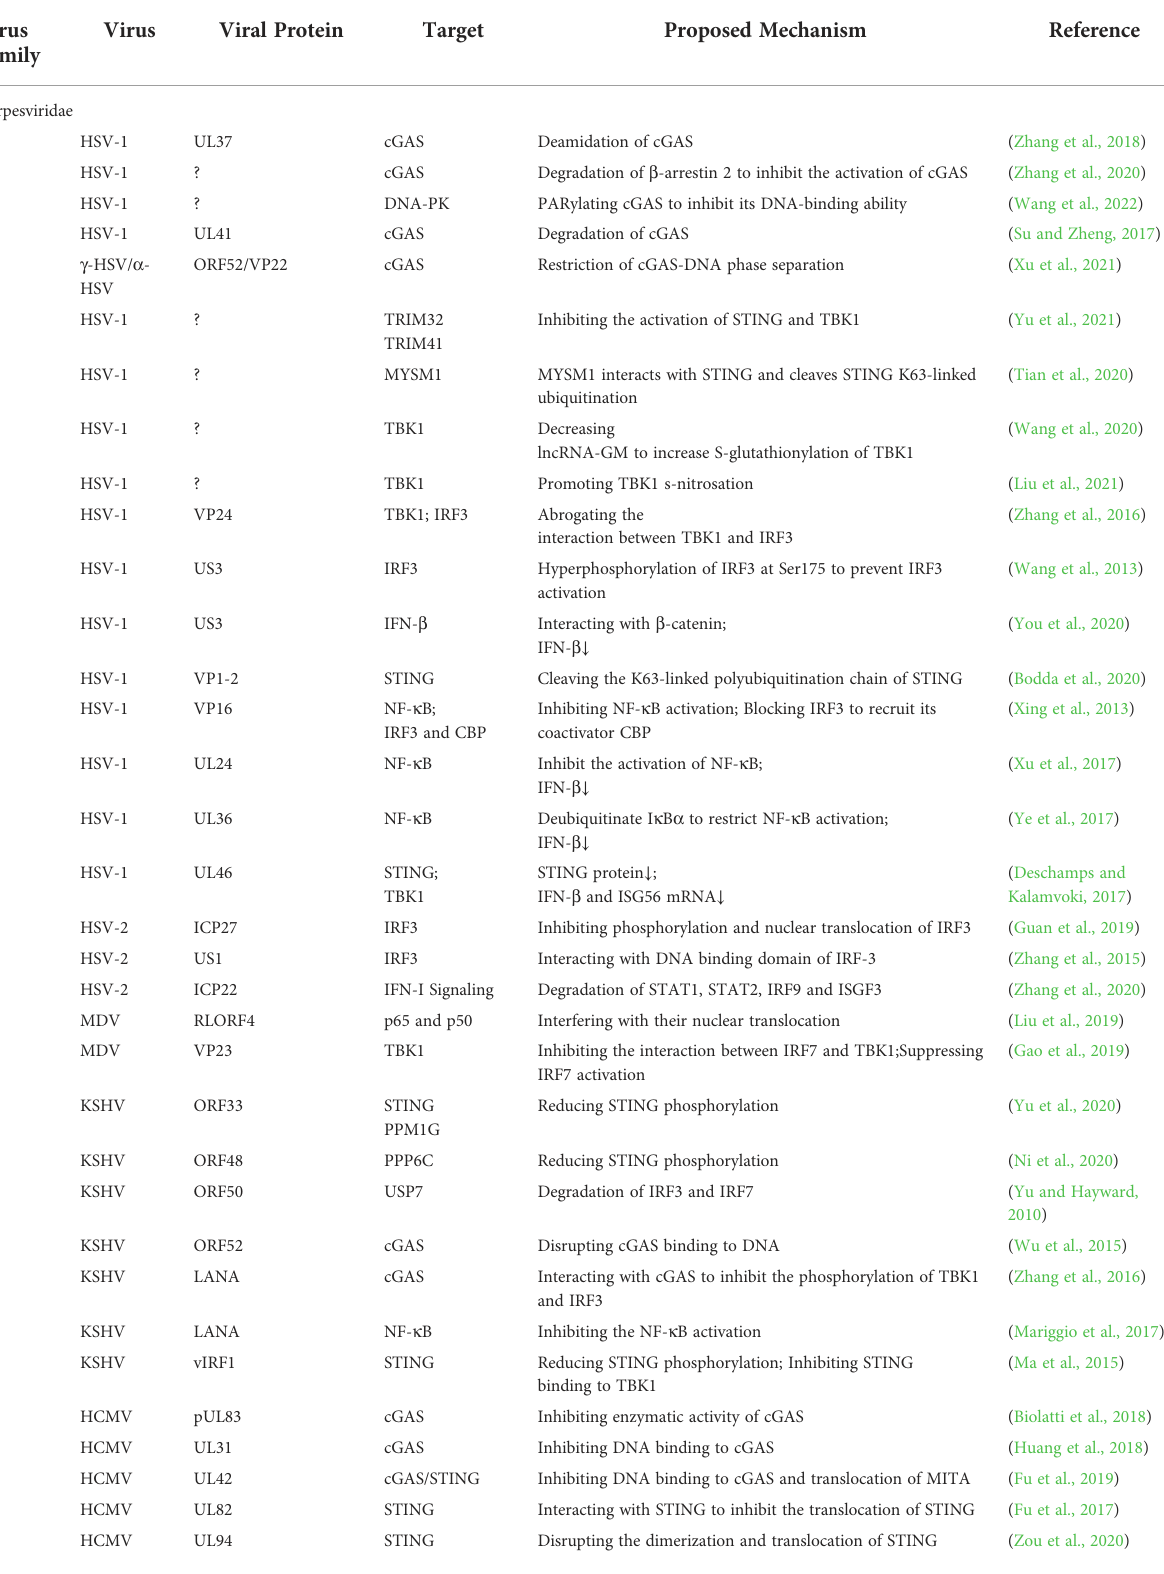
TABLE 2 Hijacking of cGAS/STING signaling by viruses. Virus